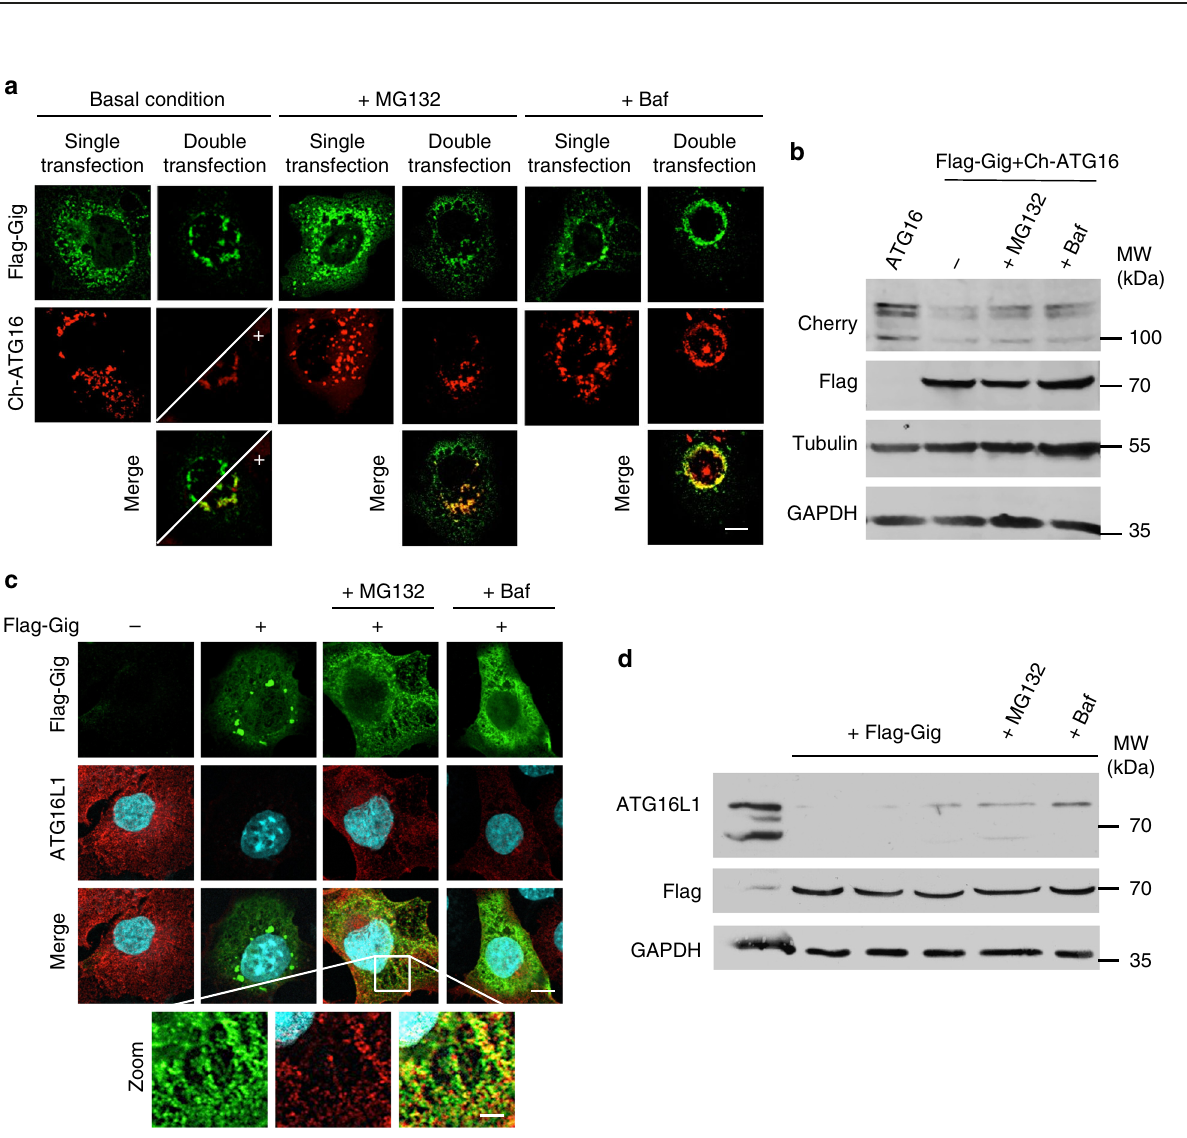
Fig. 1 Gigaxonin interacts with the WD40 domain of ATG16L1. a Immuno fl uorescence of COS-7 cells expressing Cherry-ATG16L1 (Ch-ATG16) with or without Flag-Gigaxonin (Flag-Gig). Boosting of Ch-ATG16 intensity (as shown by plus sign in the bottom panel delineated by the diagonal line) in normal condition, and MG132 treatment condition revealed a colocalisation between Gigaxonin and ATG16L1. b Reverse immunoprecipitation experiment was performed in COS-7 cells transfected with Ch-ATG16 and Flag-Gig and treated with MG132. Gigaxonin and ATG16L1 complexes were recovered using anti- fl ag (IP Flag) and anti-cherry (IP Cherry) antibodies and revealed by immunoblotting with Cherry/Flag antibodies. Immunoprecipitation with anti-IgG antibodies (IP IgG) served as negative control. c Interaction between ATG16L1 and Gigaxonin was demonstrated by bimolecular fl uorescence complementation (BiFC) assay, in transfected COS-7 cells±MG132. Interaction is visualised by the physical interaction between the N-terminal portion of YFP carrying construct (ATG16L1-N) and the C-terminal YFP construct (C-Gig). Negative controls include single transfection of ATG16L1-N, C-Gig or cotransfection of ATG16L1-N with N-Gig constructs. The dashed lines delineate the cells. d Schematic representation of the mouse ATG16L1 (ATG16L1-F) and its deletion constructs. N-terminal, central coiled-coil and C-terminal WD40 repeat domains are indicated in white, grey stripes and black, respectively. e The domain of interaction of ATG16L1 with Gigaxonin was evidenced by immunoprecipitation. Full-length and deletion constructs of Flag-ATG16 were transfected in COS-7 cells with Ch-Gig in presence of MG132. Please not that the Full-length ATG16L1 band (black star in the input panel) is enriched in pull down condition (in the IP Flag panel). Immunoprecipitation using anti-Flag antibodies evidenced Gigaxonin in the immunocomplexes formed by the Full-length-, C- and Δ N- ATG16L1 proteins. Negative controls include immunoprecipitation of the Ch-Gig + Flag-ATG16L1-F cell lysate with anti-IgG antibodies (IP IgG). f Schematic representation of the human Gigaxonin (Gig-F) with its N-terminal BTB (stripes) and C-terminal Kelch (black) domains and the BTB and Kelch deletion constructs. g Immunoprecipitation of Flag-Gig complexes identi fi ed Ch-ATG16 with both deletion constructs of Gigaxonin, Scale bar: 10 µ m